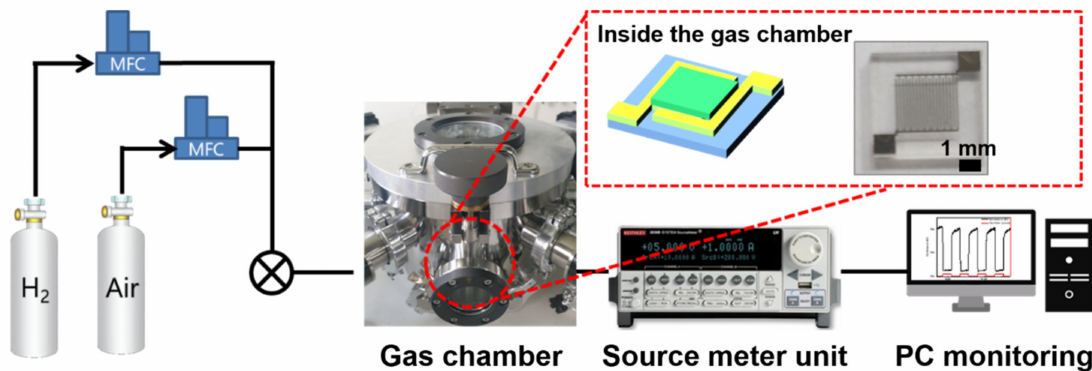
Figure 2. Schematic of gas sensing